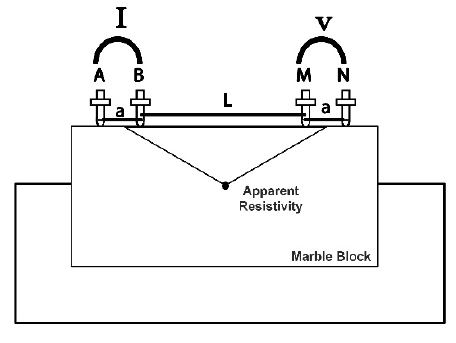
Figure 2. Dipole-Dipole Array. Table 2. Resistivity/Conductivity of Metamorphic